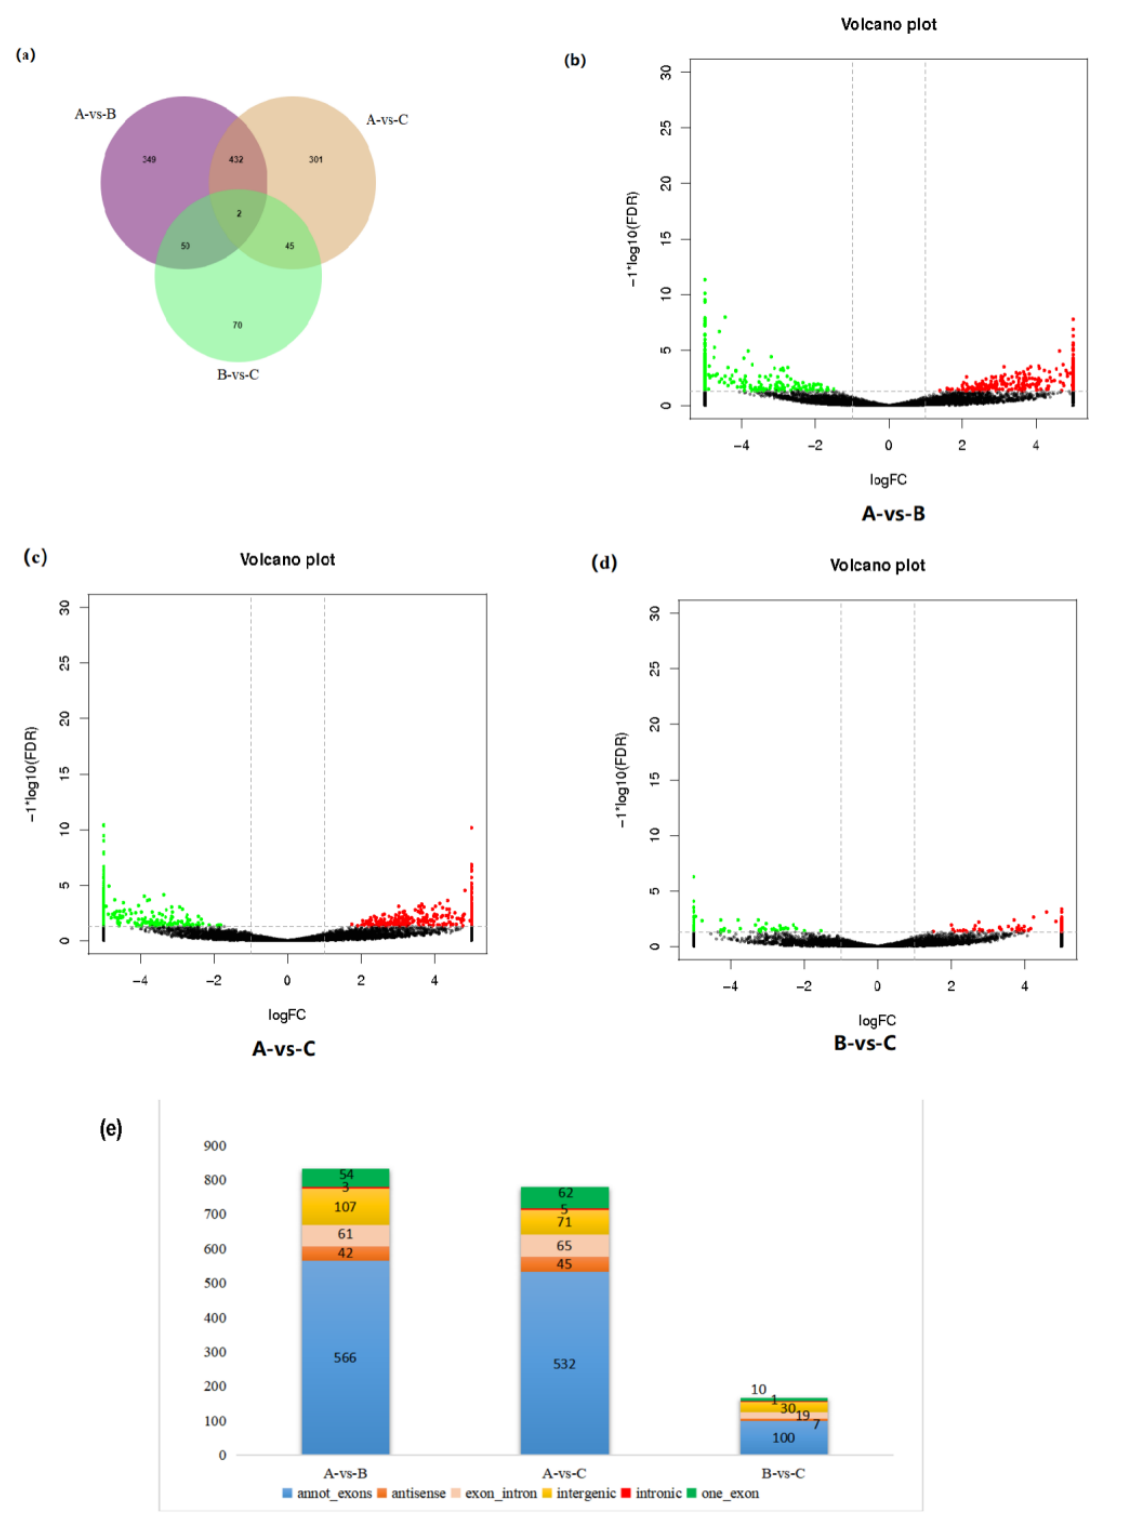
Figure 4. DEcircRNA analysis. ( a ) Venn diagram of DEcircRNAs in submandibular glands of goats at different ages. ( b – d ) Volcano plots of DEcircRNAs in submandibular glands of goats at different ages. ( e ) Bar graph and types of DEcircRNAs in submandibular glands of goats at different ages.